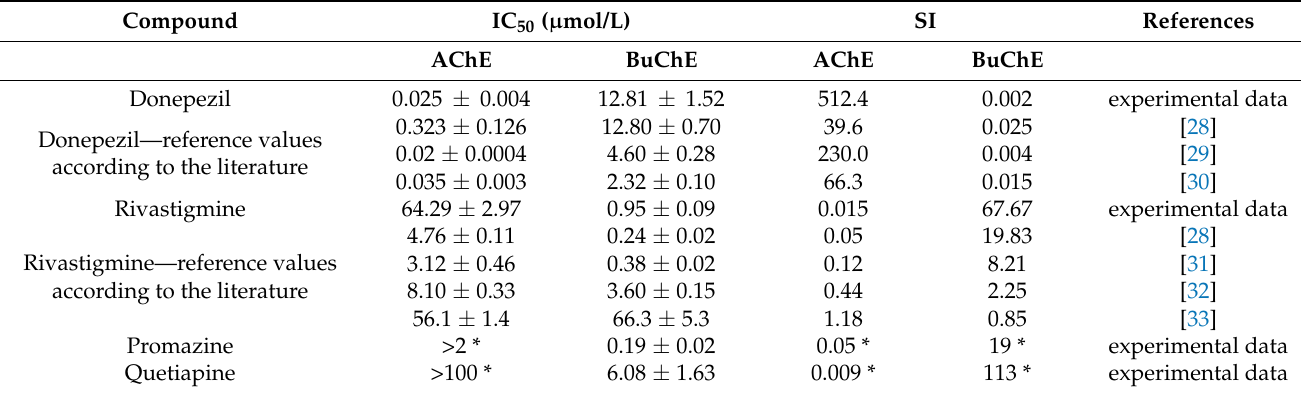
Table 1. Effects of donepezil, rivastigmine, promazine and quetiapine on human erythrocyte acetyl- cholinesterase and plasma butyrylcholinesterase activity. Results of IC 50 are presented as mean ±